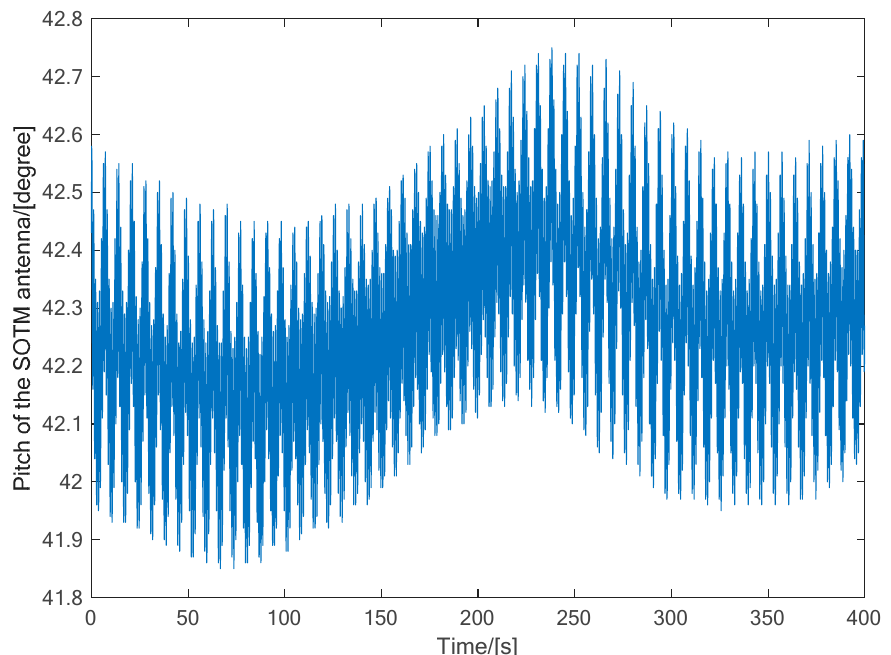
Figure 13. Pitch angle of the SOTM antenna of the conventional method.